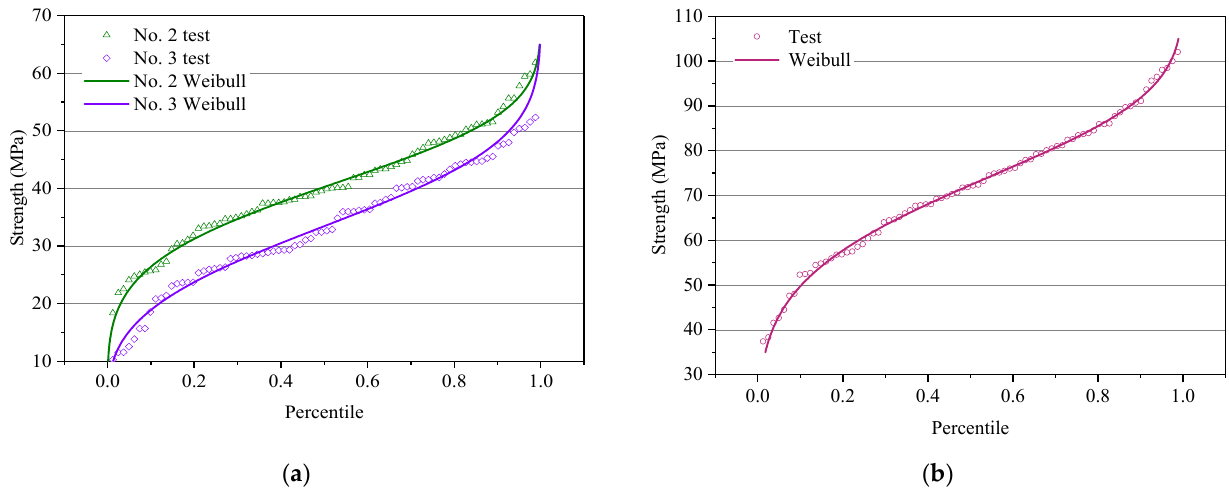
Figure 3. Short-term bending strength distributions. ( a ) Dimension lumber, ( b ) Small clear specimen. Table 2. Parameters of the short-term bending strength.